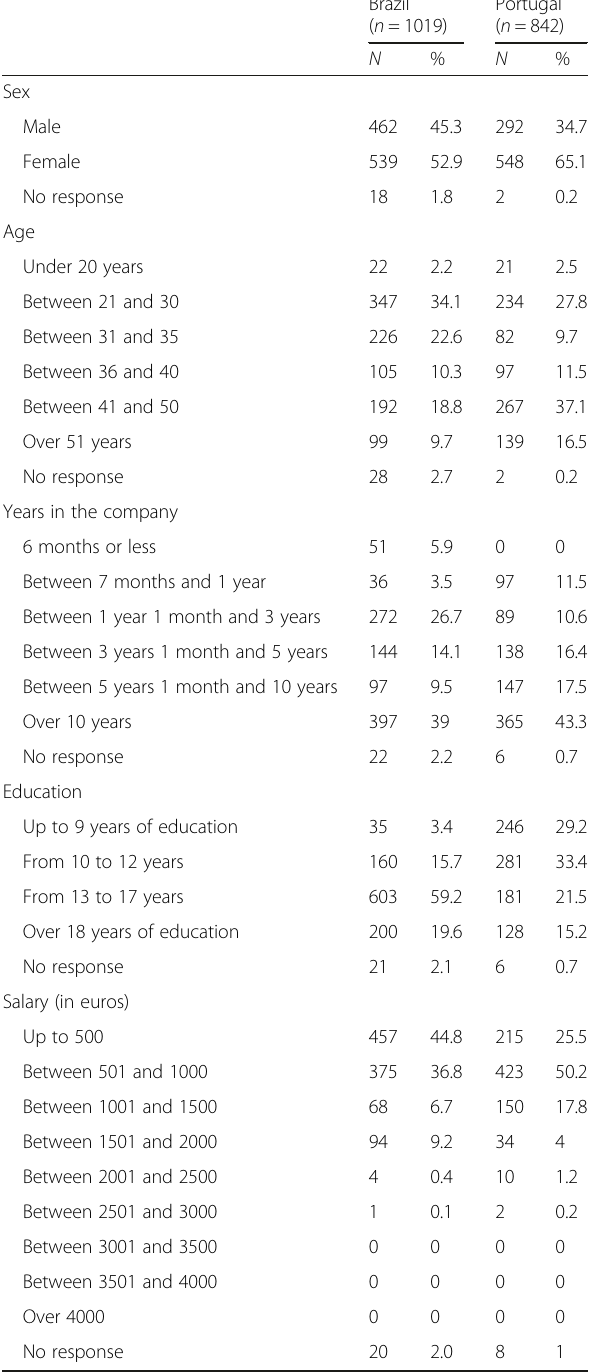
Table 1 Socio-demographic characterization of the Brazilian and Portuguese